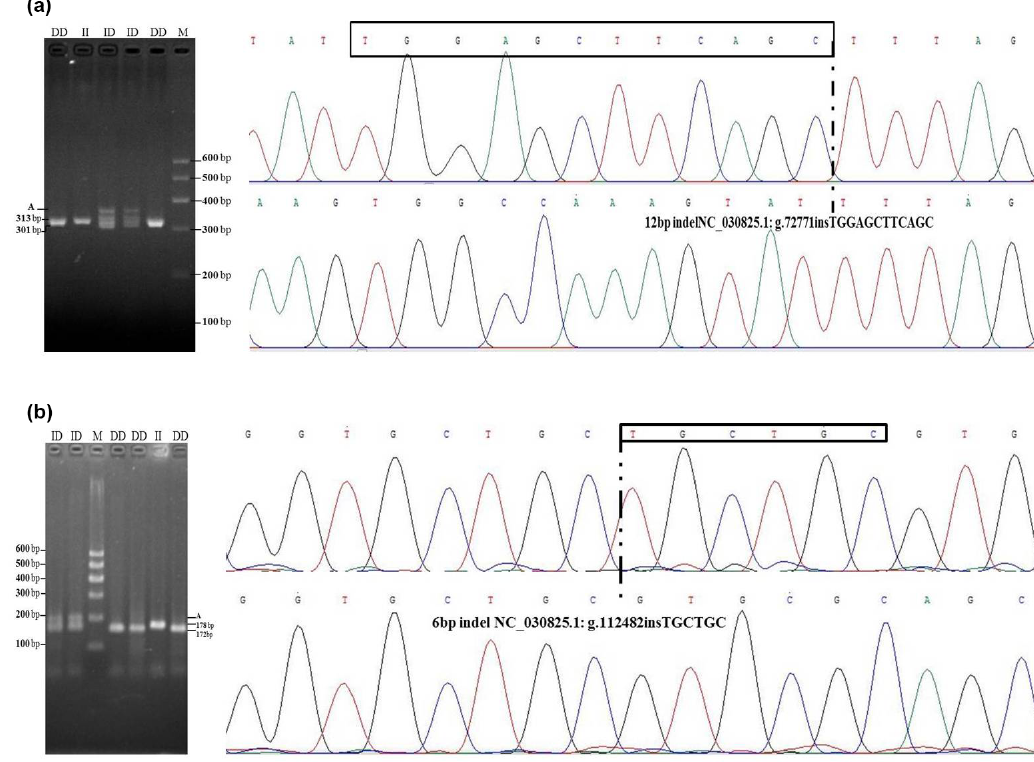
Figure 1. Agarose gel electrophoresis patterns and sequencing maps for the ATBF1 gene P1-12-bp indel and P11-6-bp indel. (a) For the P1-12-bp, PCR products showed three genotypes at this locus where the insertion type (II genotype) consisted of 313 bp, deletion type (DD) consisted of 301 bp, and the heterozygote type (ID) showed 313 and 301 bp, which accounted for 3.5% in agarose gel electrophoresis. Sequencing maps showed the homozygotic insertion type (II) and homozygotic deletion type (DD) of P1-12-bp. (b) For the P11-6-bp indel, PCR products showed three genotypes at this locus: the insertion type (II genotype, 178 bp), the deletion type (DD, 172 bp), and the heterozygote type (ID, 178/172 bp), which accounted for 3.5% in agarose gel electrophoresis. Sequencing maps showed the homozygotic insertion type (II) and the homozygotic deletion type (DD) of the P11-6-bp